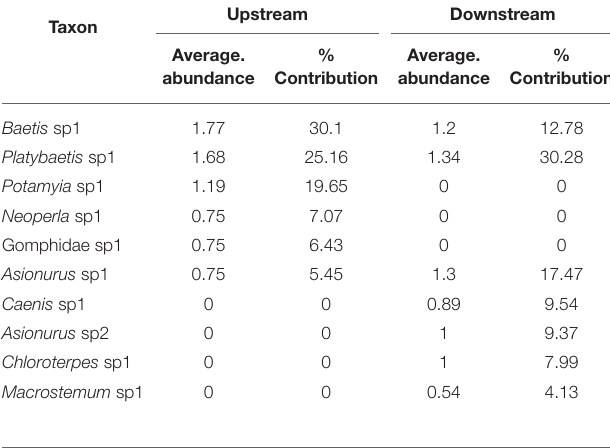
TABLE 9 | The percentage of contribution of EPTO taxa with their average abundance between sampling periods (November–December 2016